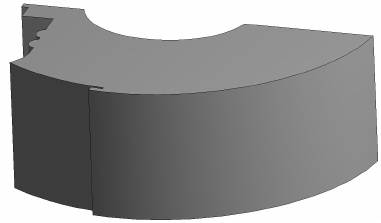
Figure 14. Building with Coons surfaces